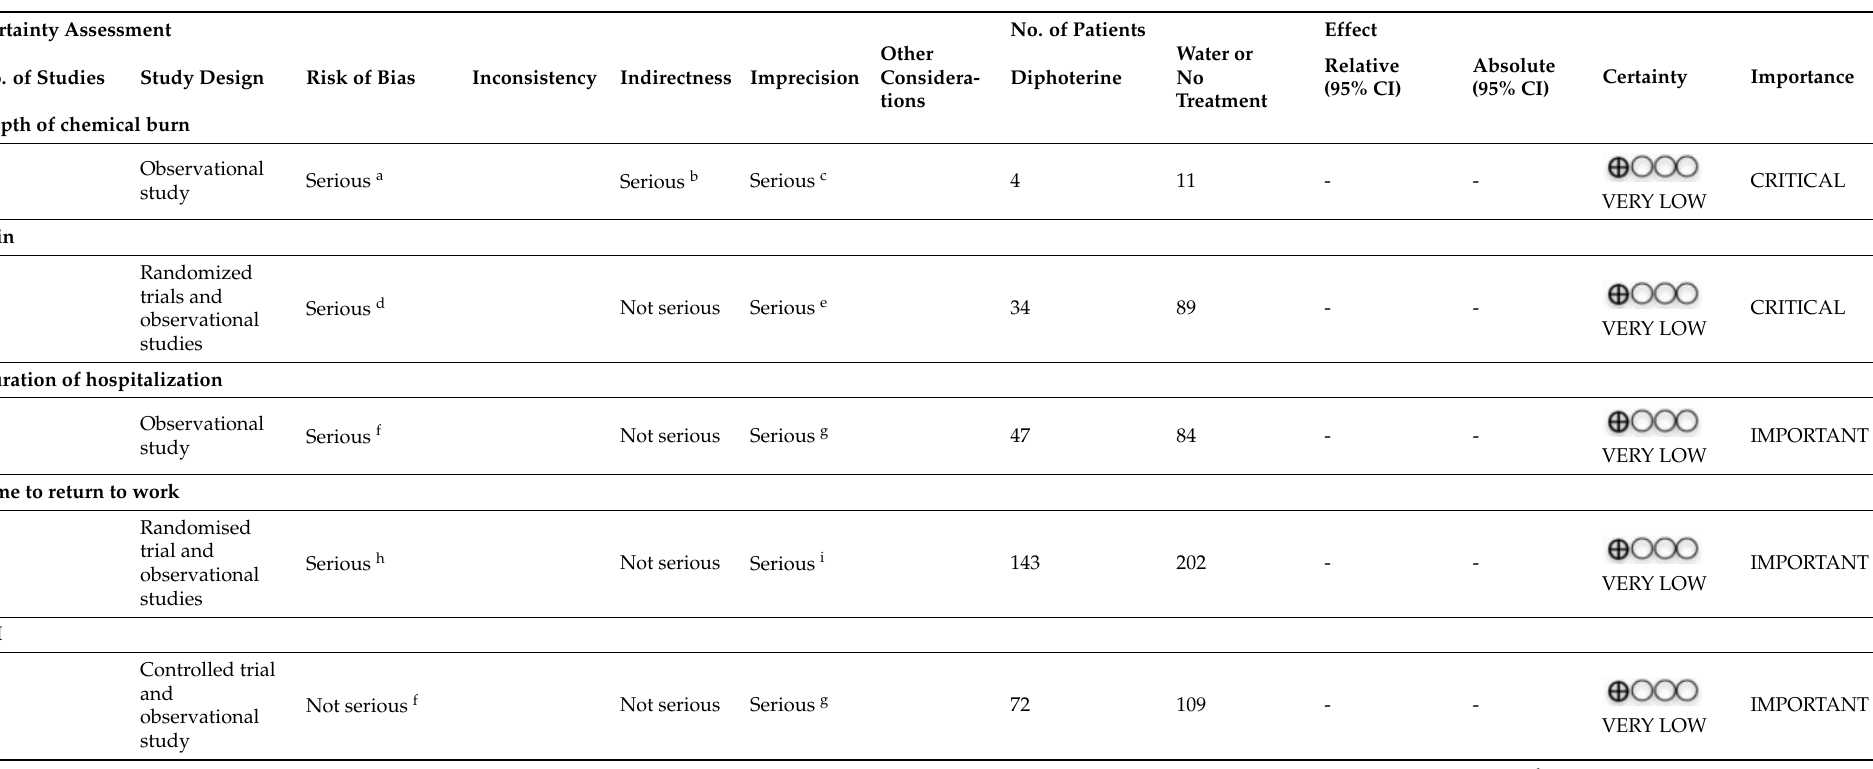
Table 4. GRADE assessment. Author(s): Felicia Dinesen. Question: Diphoterine compared to water or no treatment for chemical burns of the skin. Bibliography: [8,12–19].